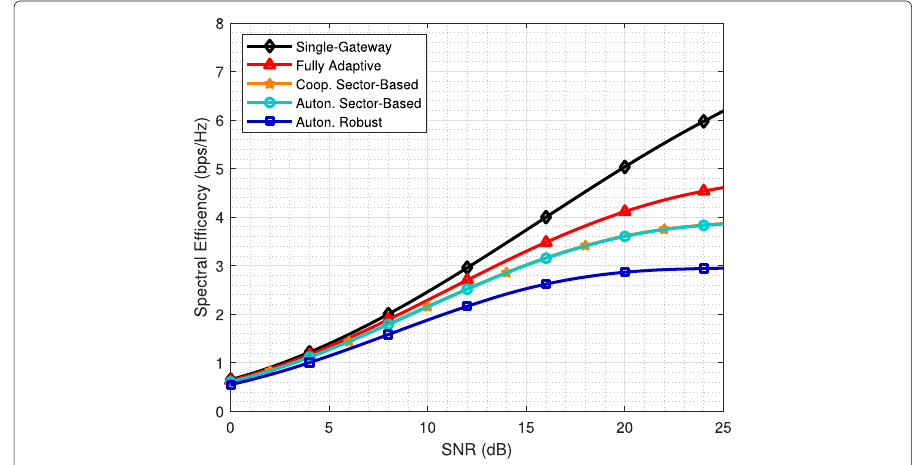
Fig. 10 Numerical results for 2 users per